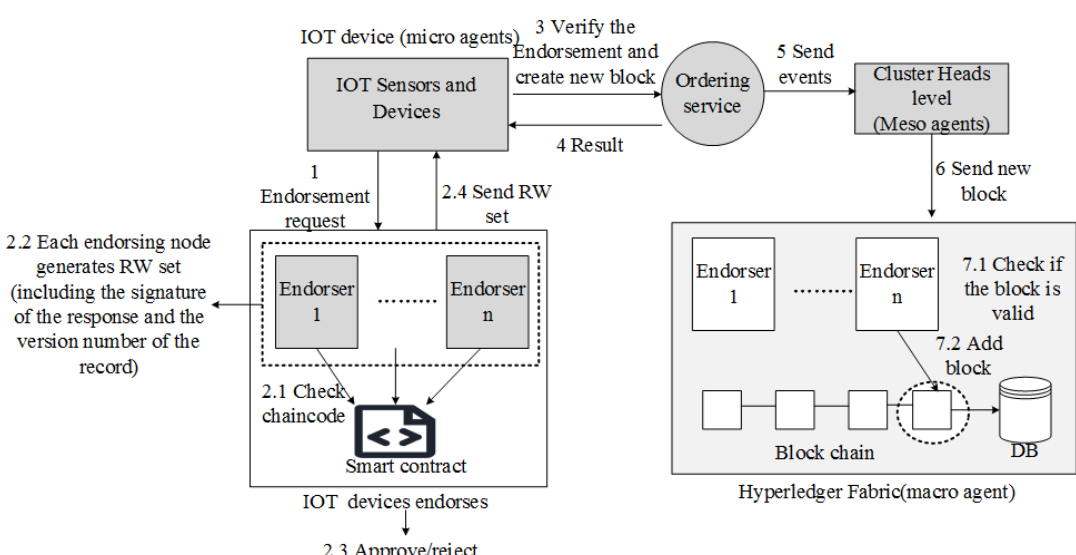
Figure 8. Reconstruction diagram of reference [29].